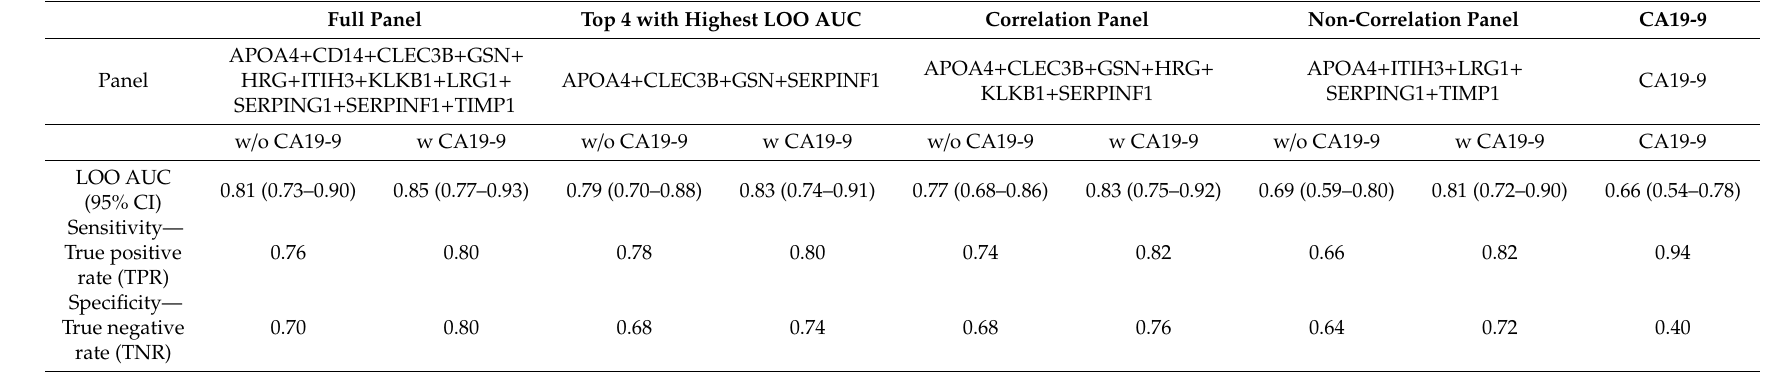
Figure 6. ROC analysis for the testing cohort using random forest combined with LOO approach. ( A ) Full panel, ( B ) Top-4 panel, ( C ) Correlation panel, ( D ) Non-correlation panel. Table 3. Summary of LOO-ROC analysis on biomarker panels.